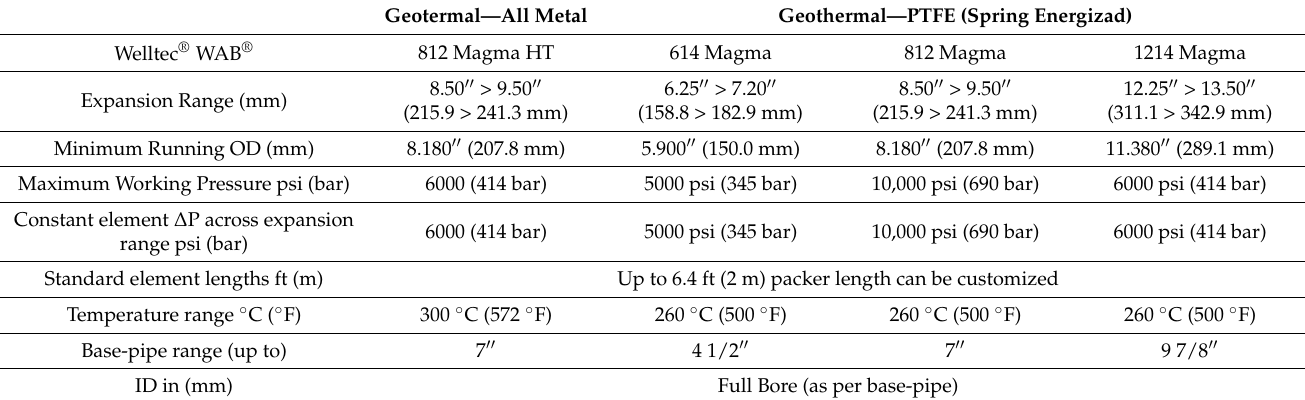
Table 7. WMP operational details for EGS